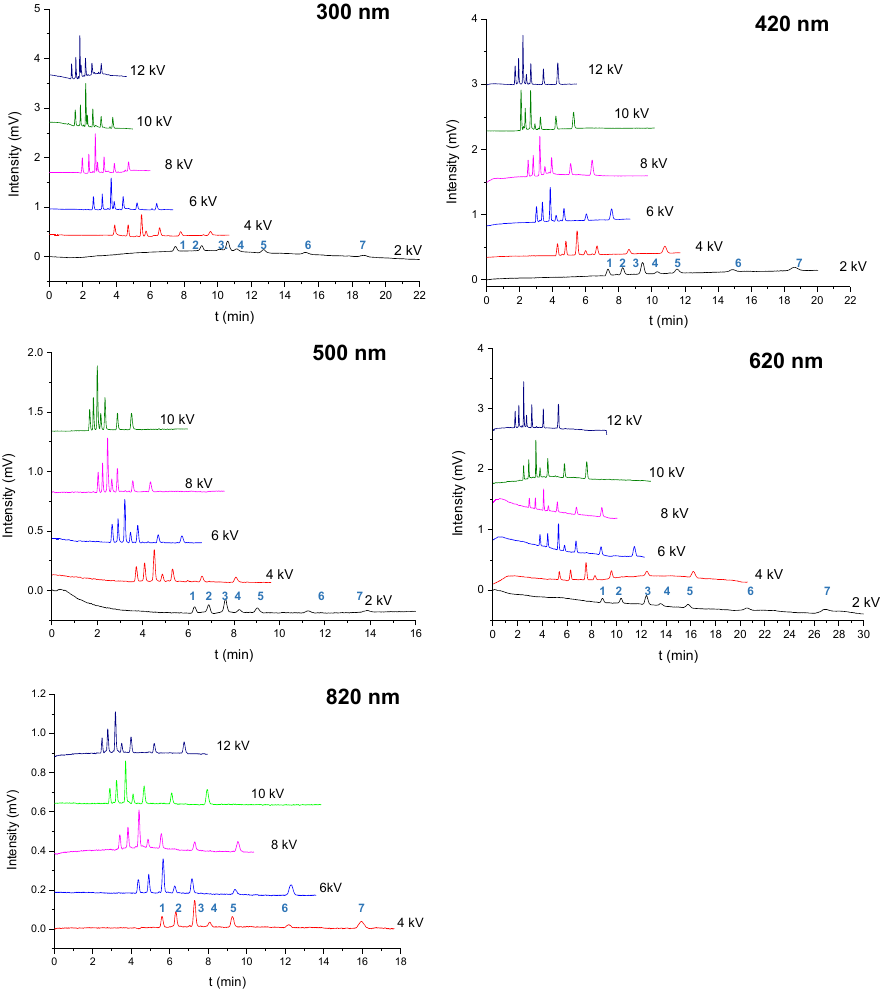
Figure 4. The pCEC separation of the thiourea and 6 aromatic compounds at voltages of 2 kV to 12 kV in the columns packed with 300, 420, 500, 620, and 820 nm particles. The experimental conditions were as follows: column: 100 μ m i.d. × 100/300 mm (effective/total length); pressure = 15.5 MPa; mobile phase: acetonitrile—10 mM phosphate butter (70:30, v / v ); pH = 7.8; and split ratios of 800:1. The peaks correspond to the following: (1) thiourea; (2) a-naphthol; (3) benzophenone; (4) naphthalene; (5) biphenyl; (6) butylbenzene; and (7) phenylcyclohexane.